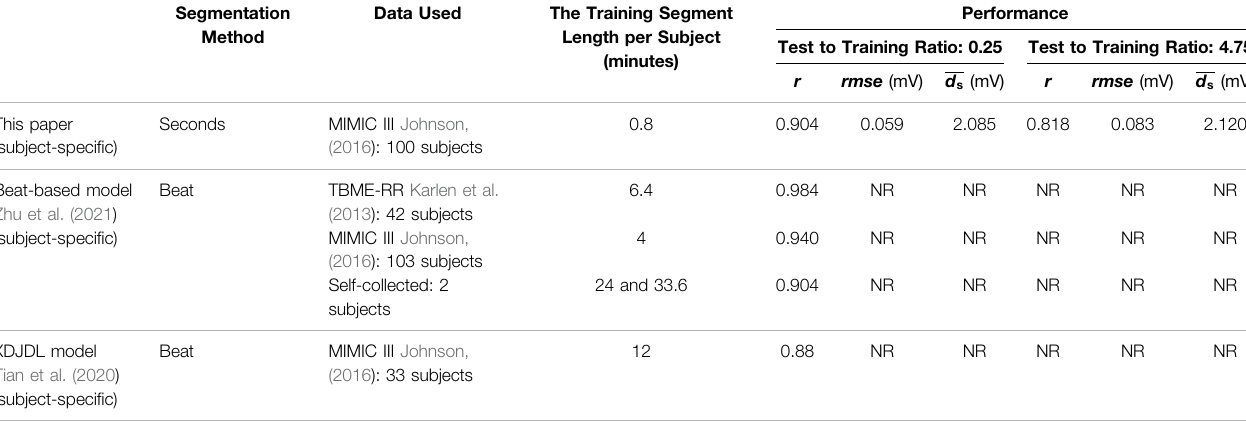
TABLE 2 | Comparison of this paper and other papers in the subject-speci fi c model. The ‘ NR ’ stands for not